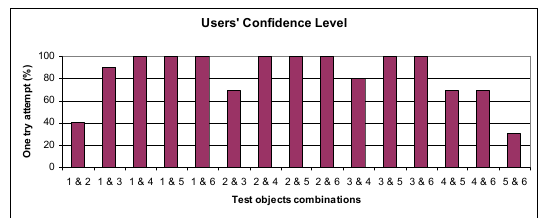
Fig. 9. Relative hardness comparison of the six test objects through the master-slave haptic gripper system.